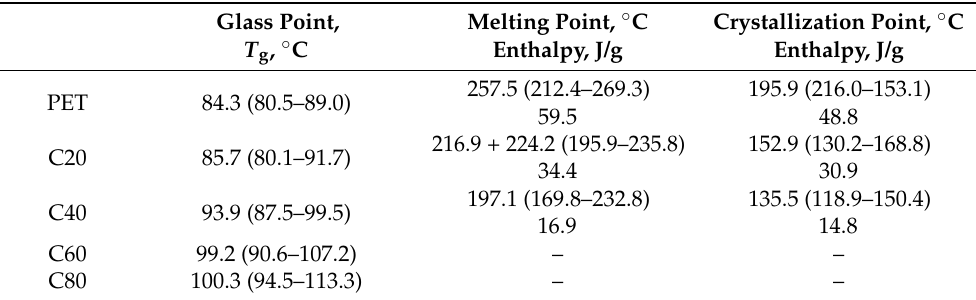
Temperatures and enthalpies of phase and relaxation transitions for PET and copolyesters C20–C80.